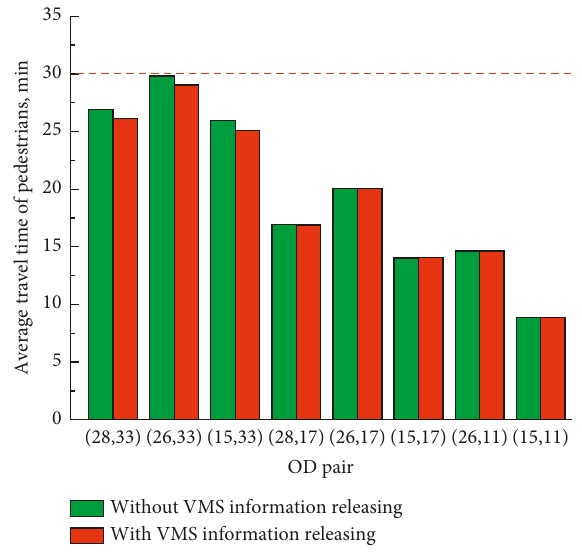
Figure 19: Distribution of travel time between each OD pair for the scenario of ingress.